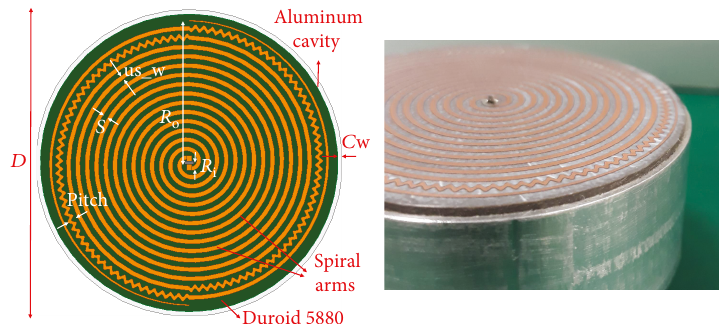
Figure 3: Top view and close-up of the cavity groove.